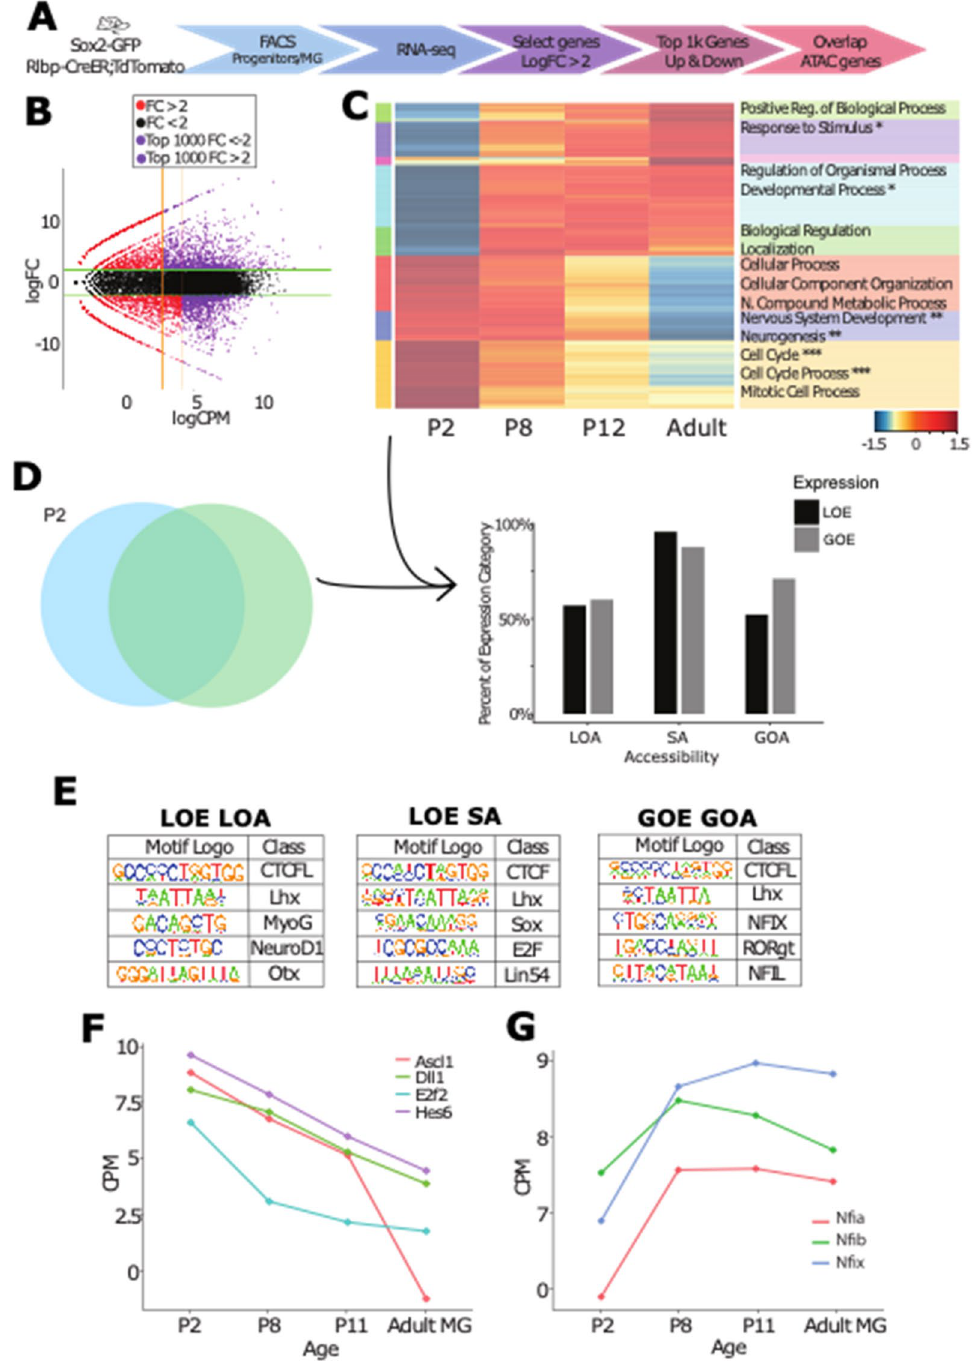
Figure 4. Glial expression and accessibility profiles follow developmental trends. ( A ) Experimental design for FACS isolation and RNA-seq of developing MG. ( B ) MA plot of expression from progenitors to adult MG demonstrating thresholds for filtering high fold change and counts for the top genes with changing expression. ( C ) Euclidian hierarchical clustering by expression changes from P2 to Adult, heat map of top gene expression (expression scale lower right), and related gene ontology categories. Categories marked with a *indicates categories that overlap with ATAC MG increased accessibility. Those marked with a** indicate where progenitor-specific accessibility overlaps, and ***indicates where shared accessibility overlaps. ( D ) Top gene expression changes were cross-compared with ATAC profiles. The percentage of genes that increase or decrease expression are represented on the y axis, split by ATAC categories (on the x axis). ( E ). Motif enrichment for accessible regions with gained expression and accessibility (GOE GOA), lost expression and accessibility (LOE LOA), and lost expression and shared accessibility (LOE SA). ( F , G ) Expression profiles of ( F ) progenitor genes of interest, and ( G ) NFI transcription